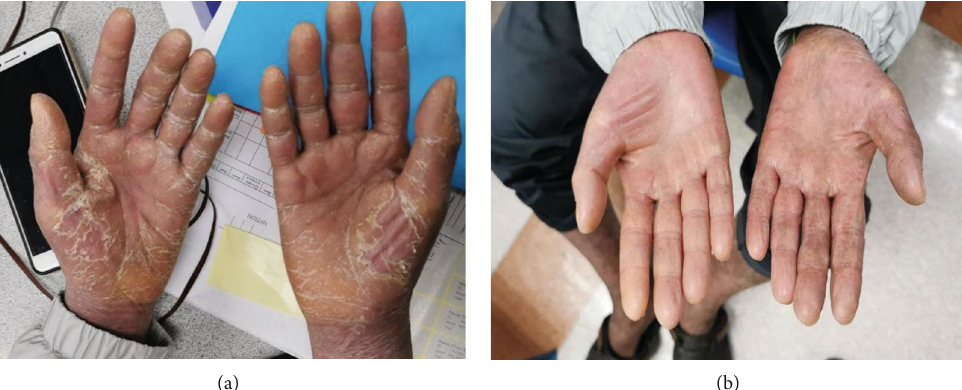
Figure 2: (a) Erythema and desquamation seen over both palms due to cutaneous chronic GVHD. (b) Signi fi cant improvement in cutaneous GVHD after ECP